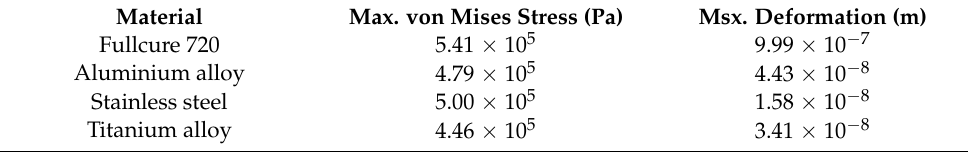
Table 7. Minimum and maximum stresses and total deformations of rotor blades at design and off-design